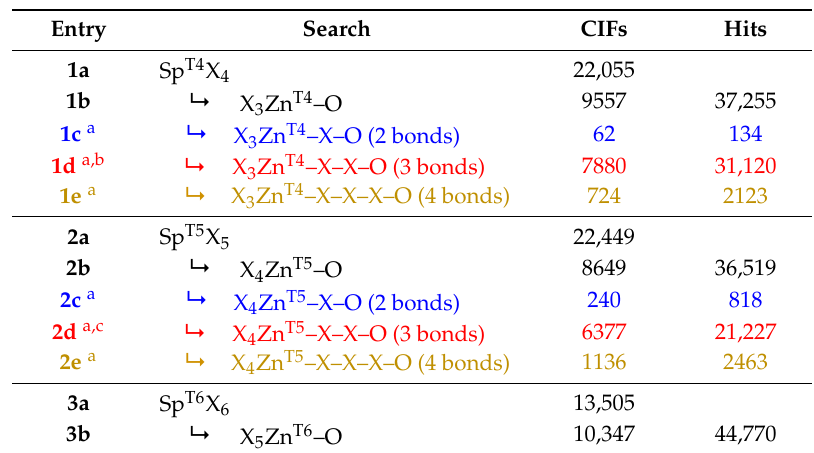
Table 3. Numerical overview of CSD data. Sp = Zn, Cd or Hg, X = any atom, all bonds could be any type of bond.